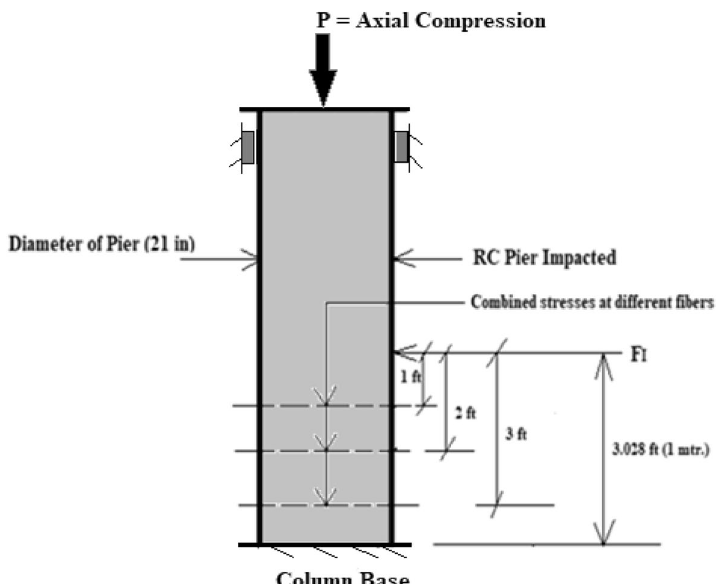
Fig. 10 Stresses in column at different fiber levels